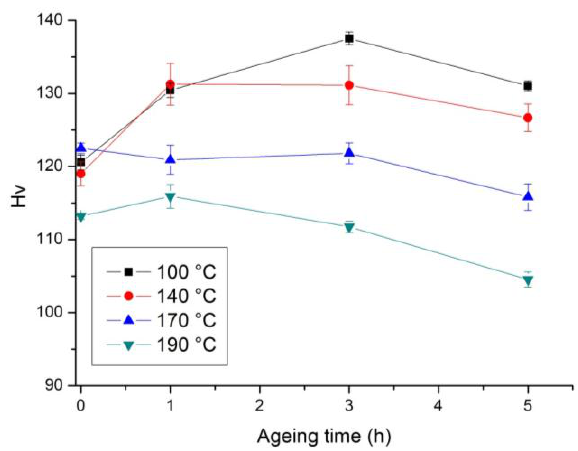
Figure 7. Micro-Vickers hardness values of the A357 samples during direct-ageing treatment at 170 °C.